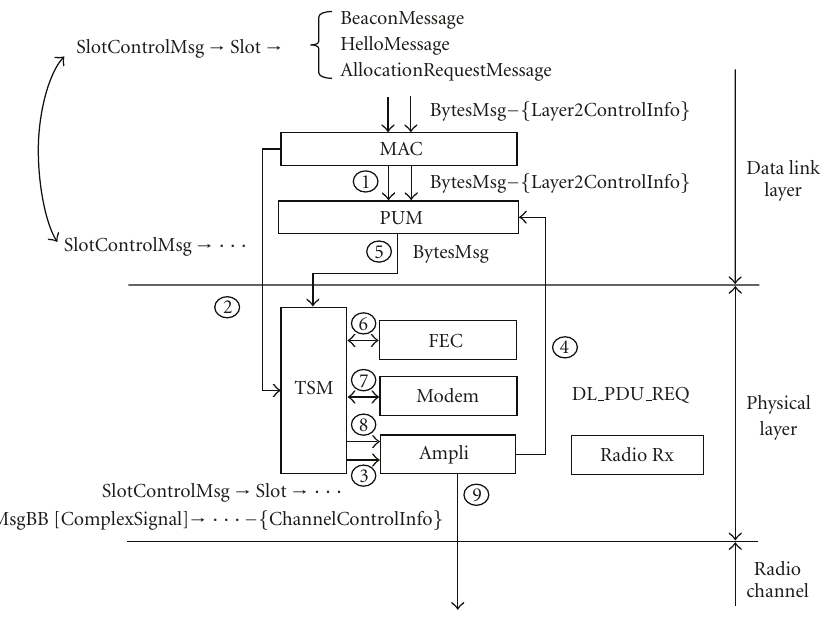
Figure 6: Radio access sequence diagram at transmission side.